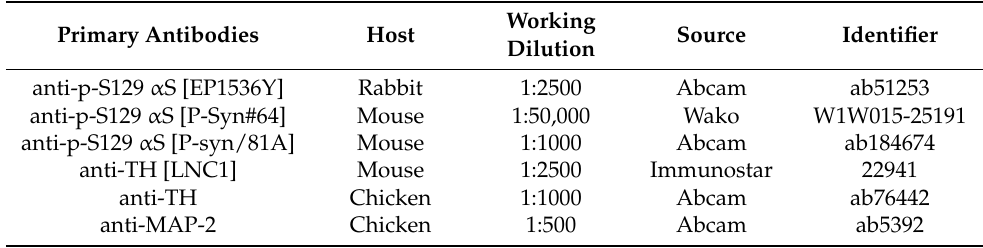
Table 1. List and details of primary